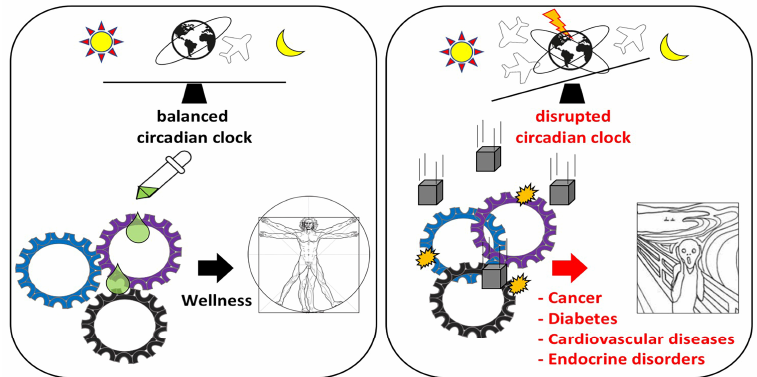
Figure 1. Effect of circadian rhythm disruption on body health. Circadian alignment is associated with wellness and body health. Circadian clock malfunctioning induced by genetic factors (clock gene mutations) and/or environmental factors (inappropriate light exposure, sleep restriction, jetlag, shift work, irregular food intake) can lead to the development of several disorders including cancer, diabetes, cardiovascular disorders, endocrine diseases, inflammation, mental disorders, immune system alterations and reproductive disorders.